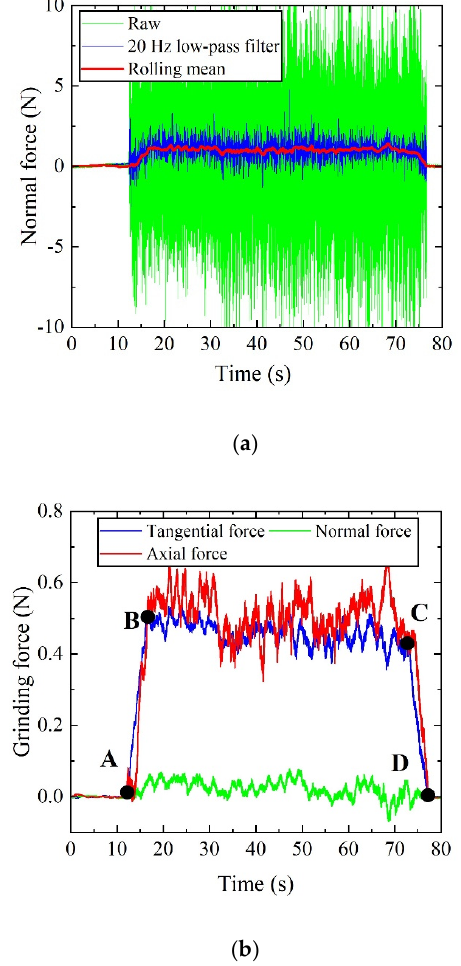
Figure 8. ( a ) Force profile recorded during an experiment. ( b ) Profiles of tangential force, axial force and normal force after filtering and smoothing.